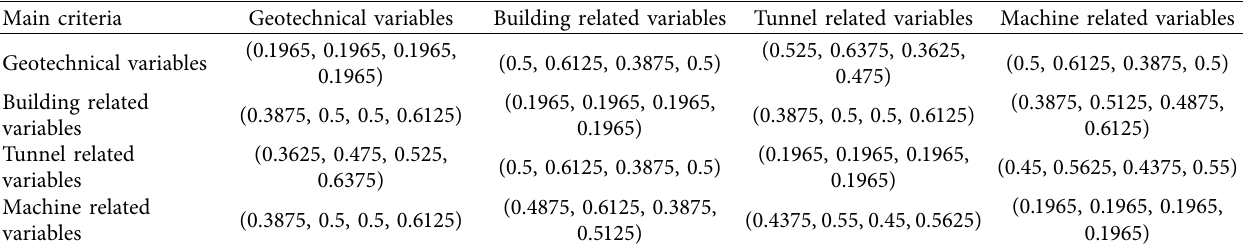
Table 4: Compromised pairwise comparison matrix of the main